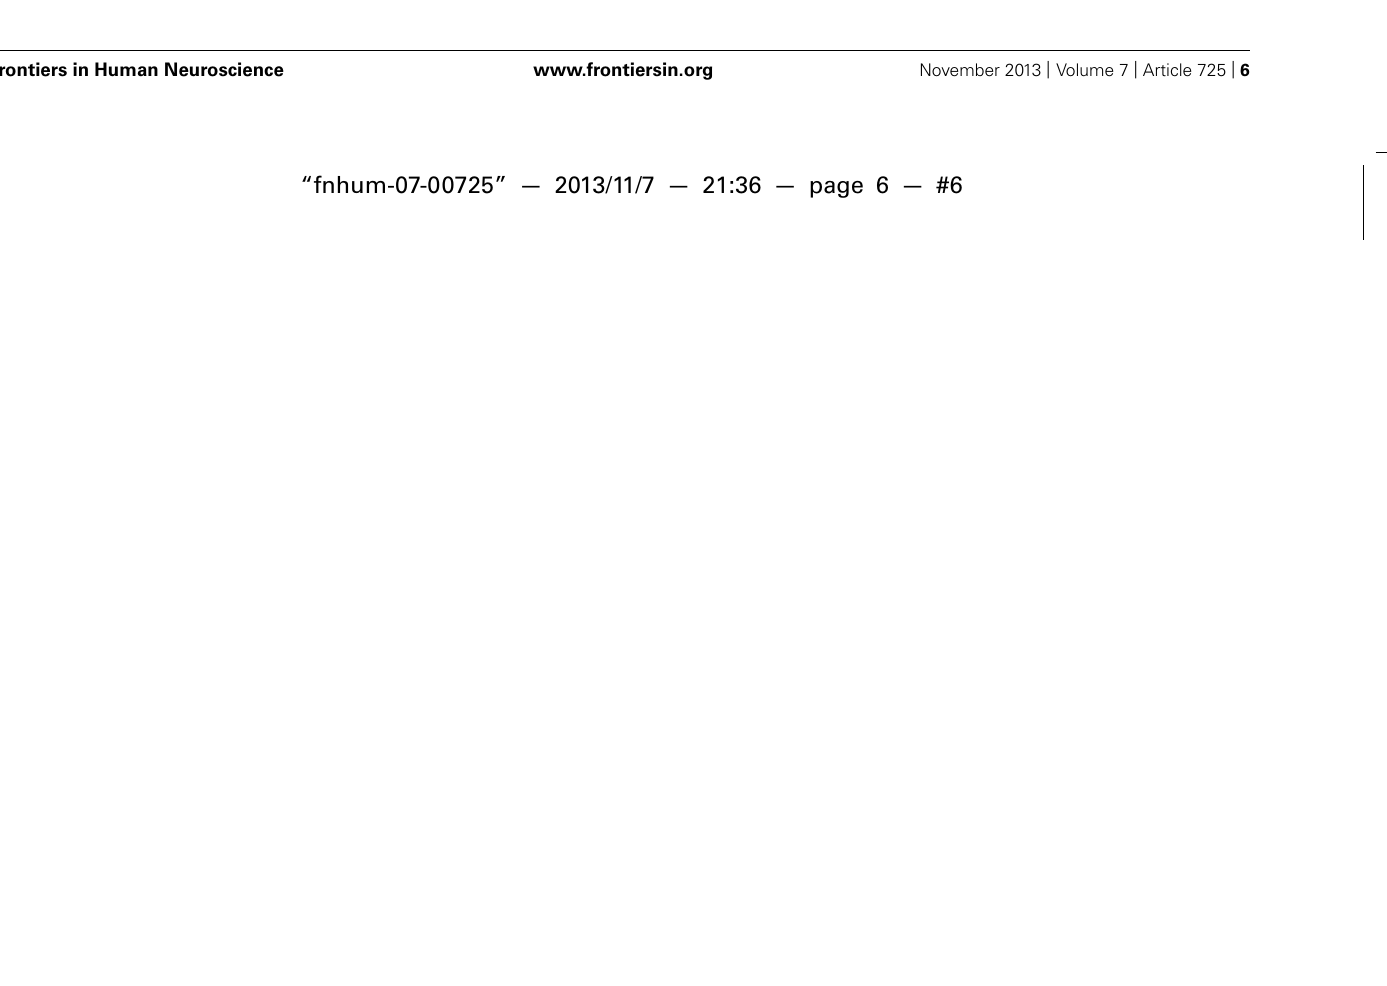
FIGURE 3 | (A) Activity for action words in control (blue) and ASC (red) participants ( p < 0. 005, uncorr.). Bar charts depict action-word activity for both groups in key inferior frontal and precentral ROIs. (B) Activity for object words in control (blue) and ASC (red) participants ( p < 0.005, uncorr.). For further explanation, see legend for (A) . In (A,B) , values along the y -axis reflect parameter estimates (arbitrary units) reflecting the difference in activation between action or object words respectively and the baseline condition